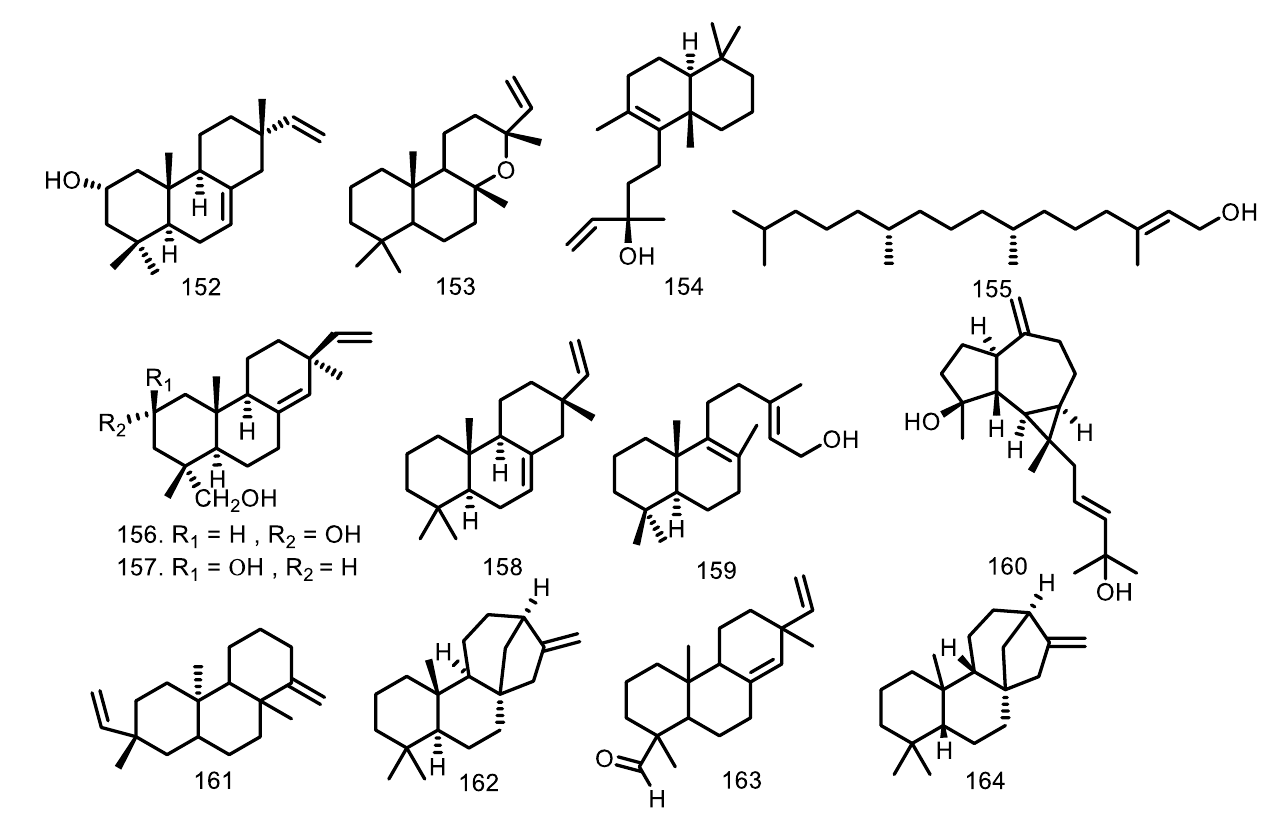
Figure 4. Diterpenoid from Guarea species.